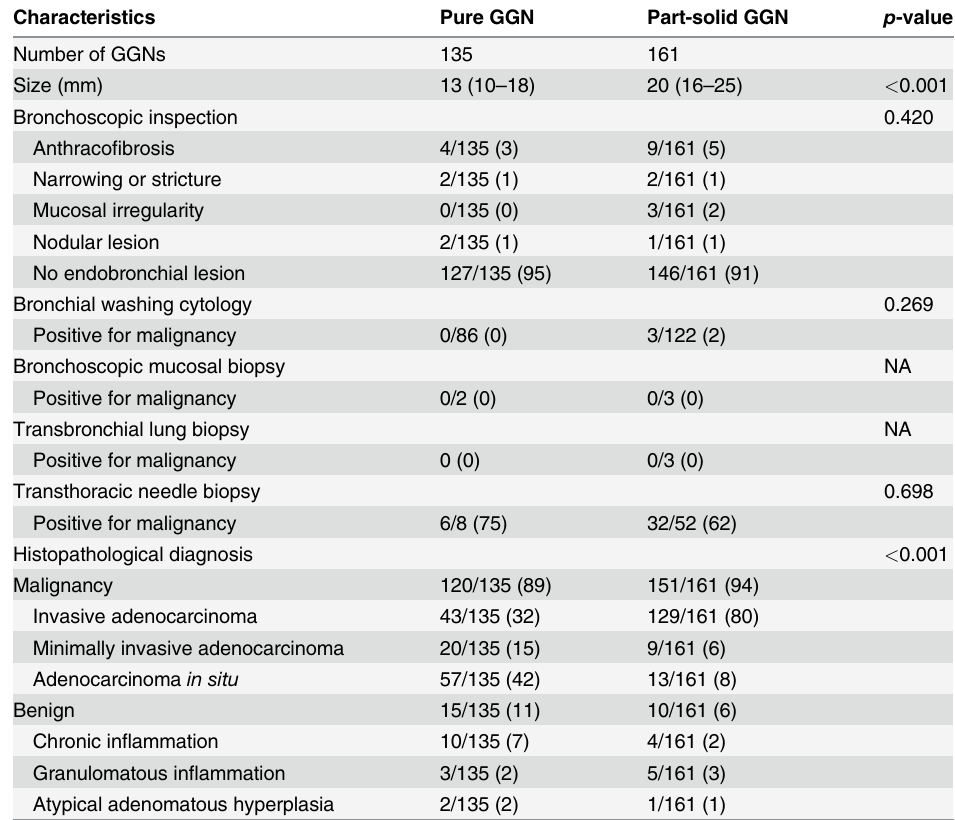
Table 3. Results of diagnostic evaluation according to characteristics of